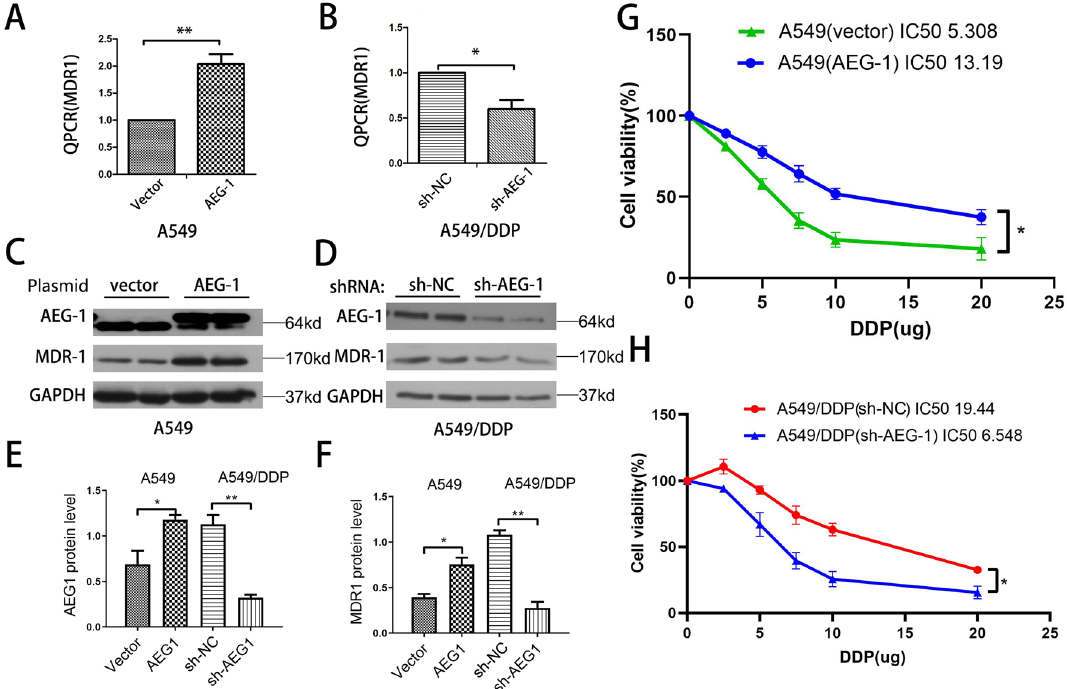
Figure 2. The effect of AEG-1 and MDR-1 on the killing effect of platinum in A549 and A549/DDP cells. ( A – D ) A549 and A549/DDP cells overexpress AEG-1 and knock down AEG-1, AEG-1 and MDR-1 respectively; ( E , F ) Quantitative analysis of WB results; ( G , H ) overexpress AEG-1 and knock down AEG-1 respectively. The killing effect of platinum on A549 and A549/DDP